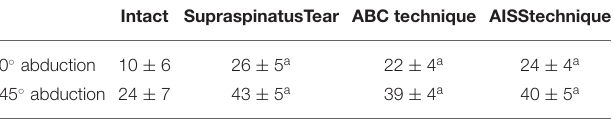
TABLE 2 | Total rotational range of motion (in